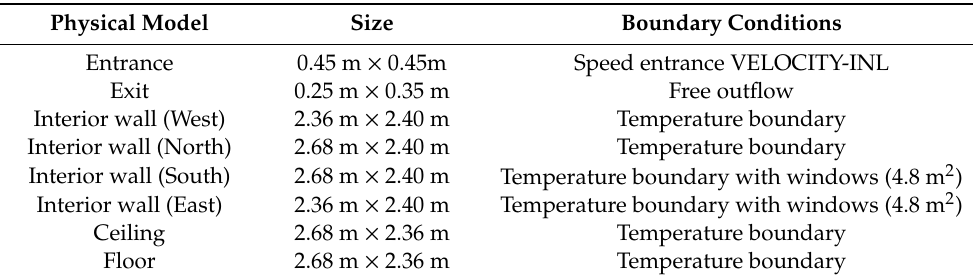
Table 3. Setting of boundary conditions.